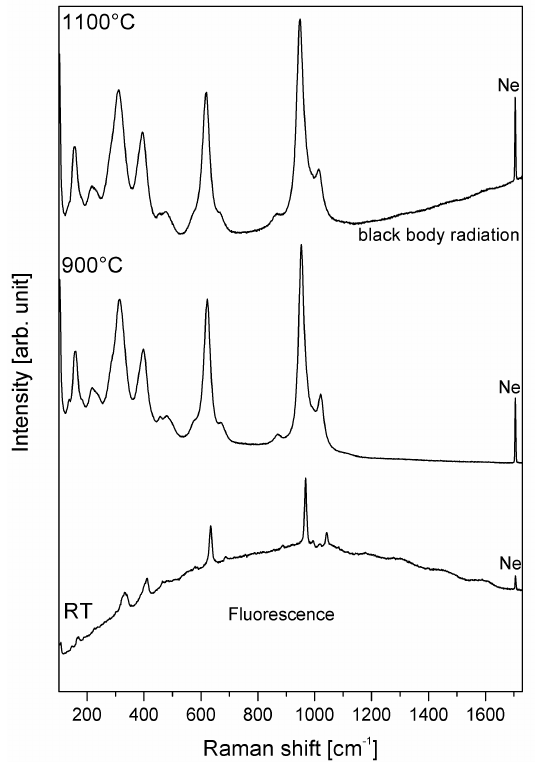
Figure 4. Raw spectra of wollastonite recorded at room temperature (RT), 900 °C, and 1100 °C, showing the temperature-dependent difference of the background that is dominated by fluorescence and black body radiation at low and high-temperatures, respectively.